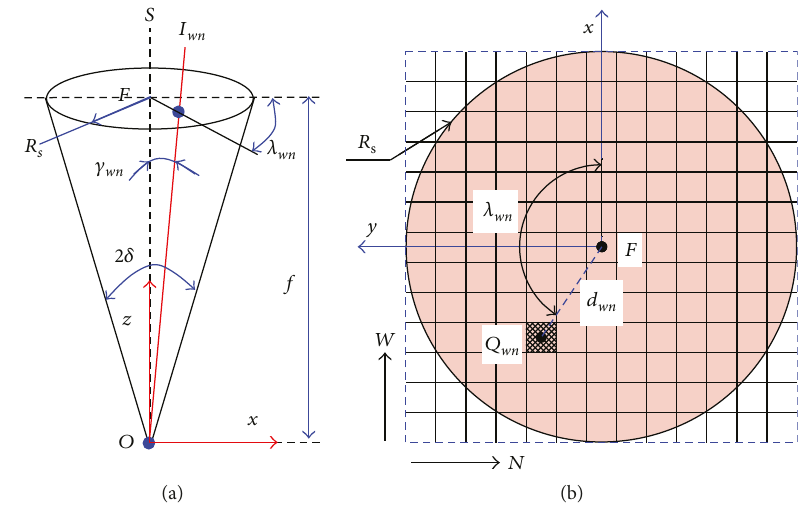
Figure 3: Discretization of the (a) sun cone and (b) solar